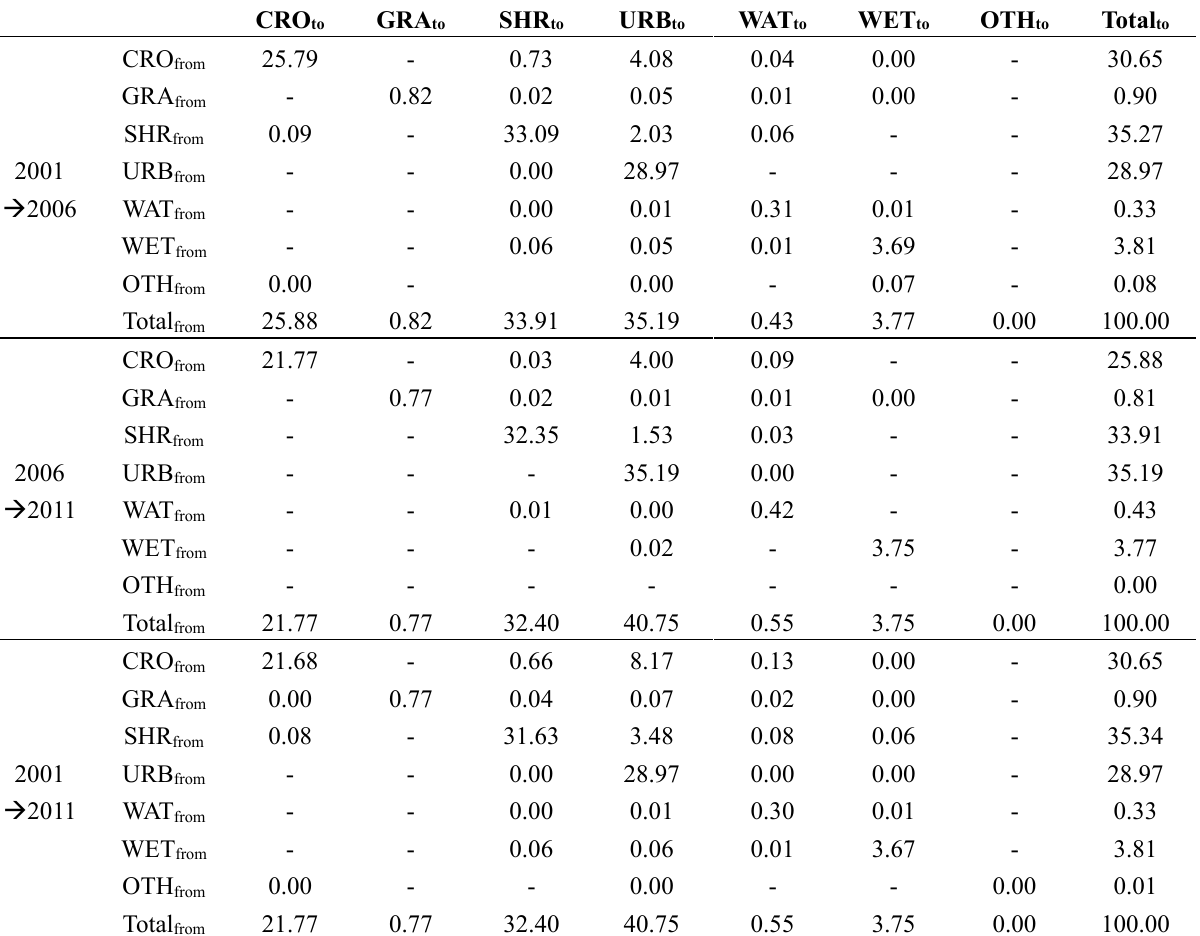
Table 2. Percentage (%) of land cover change for the three periods. The abbreviations CRO, GRA, SHR, URB, WAT, WET and OTH denote cropland, grassland, shrub, urban, water, wetland and others, respectively. The subscripts ‘from’ and ‘to’ denote the original and latest land cover type,